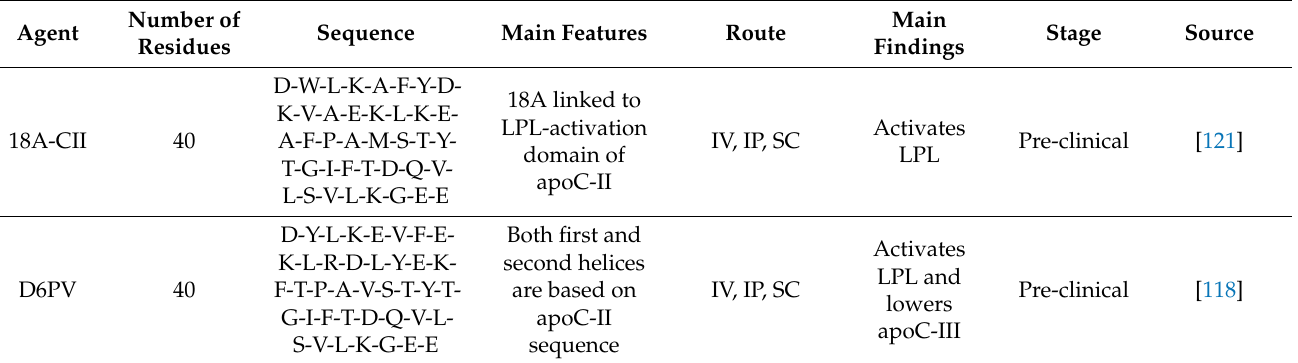
Table 5. ApoC-II mimetic